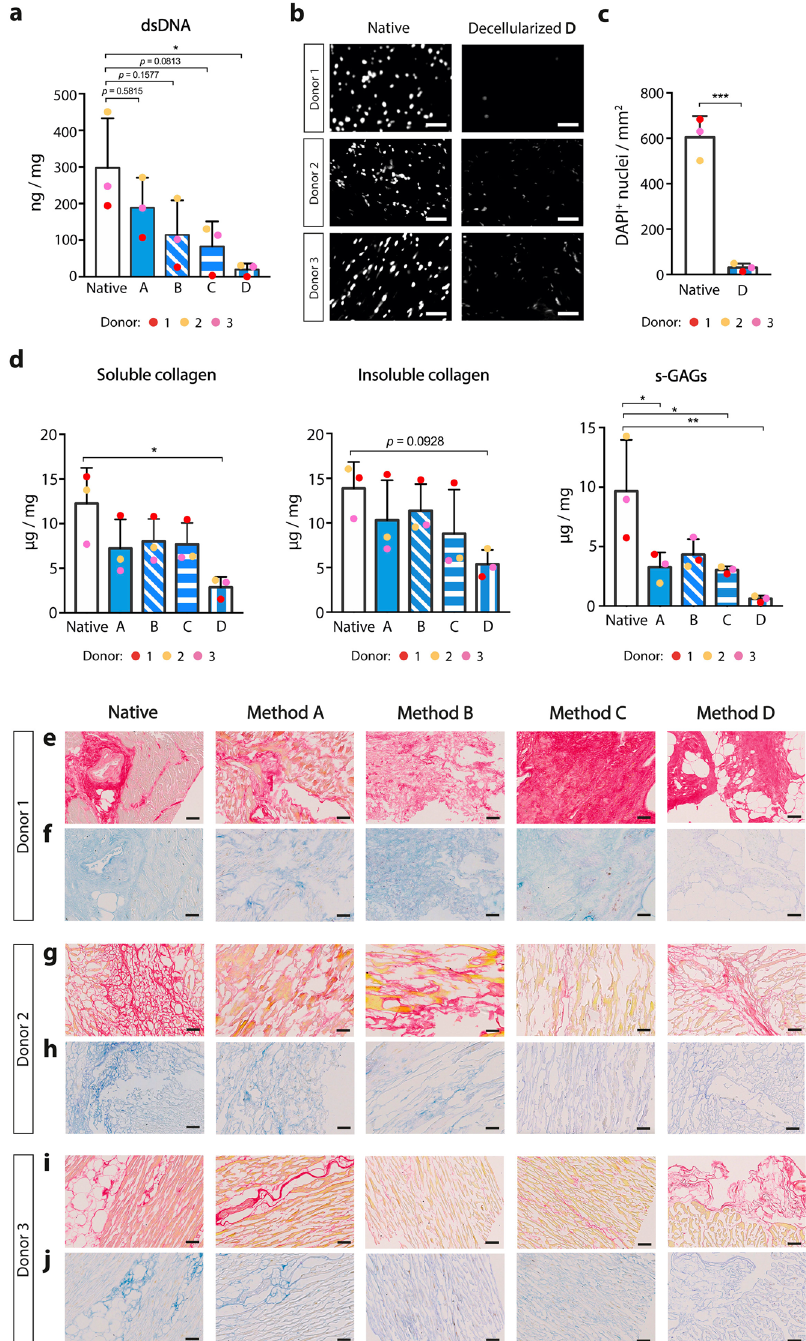
Figure 2. Biological characterization of chemical-based decellularized human cardiac tissue. ( a ) Double stranded DNA (dsDNA) content of native and decellularized cardiac tissue for all methods, normalized to tissue wet weight ( n = 3; one-way ANOVA, F 4,10 = 4.38, * p < 0.05 with Tukey’s multiple comparison test). ( b ) Immunofluorescence of nuclei (DAPI, white) in native and decellularized tissue through method D for each donor. Scale bars: 50 µm. ( c ) Number of DAPI + nuclei per cross-section area ( n = 3; two-tailed unpaired t -test, *** p < 0.001). ( d ) Biochemical analysis for soluble collagen ( n = 3; Kruskal–Wallis test, * p = 0.0229, * p < 0.05 with Dunnett’s multiple-comparison test), insoluble collagen ( n = 3; one-way ANOVA, F 4,10 = 2.304, following Tukey’s multiple comparison test), sulfated glycosaminoglycans (s-GAGs; n = 3; one-way ANOVA, F 4,10 = 7.709, * p < 0.05 and ** p < 0.01 with Tukey’s multiple comparison test) on native and decellularized cardiac tissue for all methods, normalized to tissue wet weight. The average of the 3 cardiac tissue donors was used as a representative value for the component in the myocardium. ( e ), ( g ), ( i ) Picro Sirius Red (PSR) and ( f ), ( h ), ( j ) Alcian Blue staining on native and decellularized tissue for all methods. Scale bars: 100 µm. Data are represented as mean ±